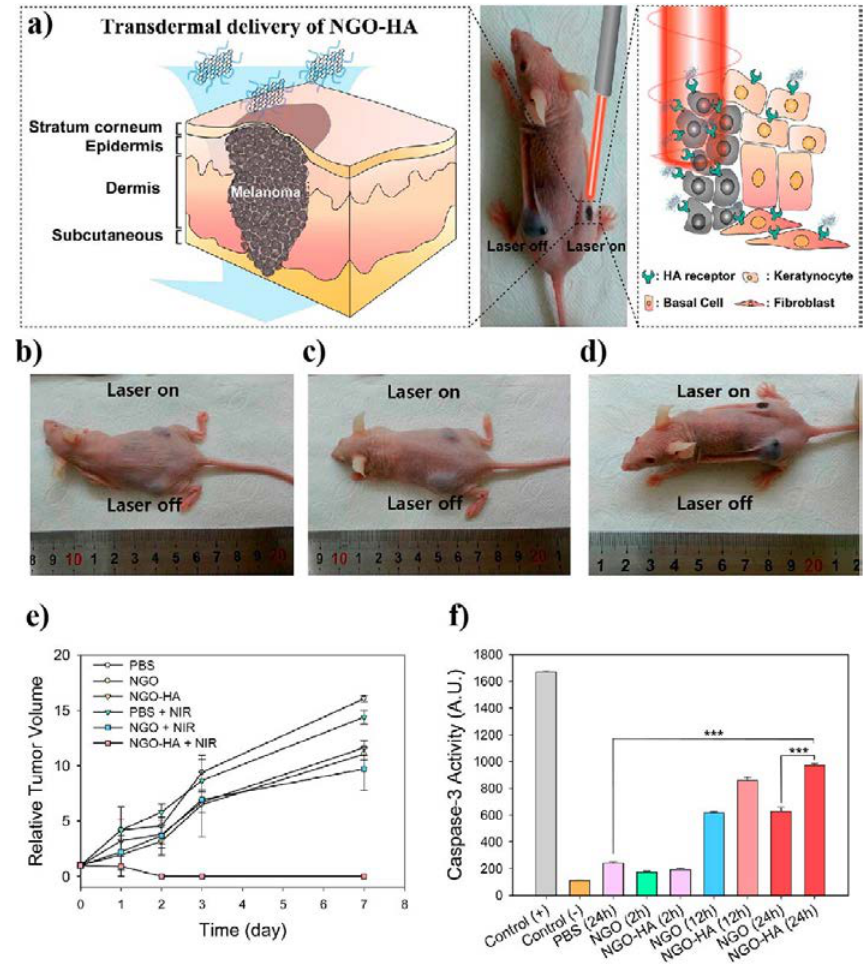
Fig. 4. Graphene-based nanomaterials for photo-therapy. (i) Photothermal therapy. (a) Schematic illustration for the transdermal delivery of nanographene oxide – hyaluronic acid (NGO – HA) conjugates into melanoma skin cancer cells and the following photothermal ablation therapy using a NIR laser. Photographs showing the e®ect of photothermal ablation therapy with NIR irradiation on the tumor growth in SKH-1 mice inoculated with B16F1 cells on both dorsal °anks after topical administration of (b) PBS, (c) NGO, and (d) NGO – hyaluronic acid (HA). (e) Relative tumor volume ( V = V 0 ) with increasing time for a week. (f) Caspase-3 activity in tumor tissues by ELISA with increasing time for a day for the analysis of heat induced apoptosis (*** P < 0 : 0001 Þ . Reproduced with permission from Ref. 84. Copyright 2014 American Chemical Society. (ii) Photodynamic therapy. MTT cell viability of HeLa cells treated with HA – GO/Ce6 nanohybrids ( W Þ or free Ce6 ( (cid:4) ) for 6h, followed by the light irradiation of 1.8J cm (cid:1) 2 (a), or without the light irradiation (b); LIVE/DEAD cell viability of HeLa cells treated with HA – GO/Ce6 nanohybrids or free Ce6 at a Ce6 concentration of 0.1 (cid:2) g mL (cid:1) 1 for 6h of treatment (c). Reproduced with permission from Ref. 94. Copyright 2013 Royal Society of